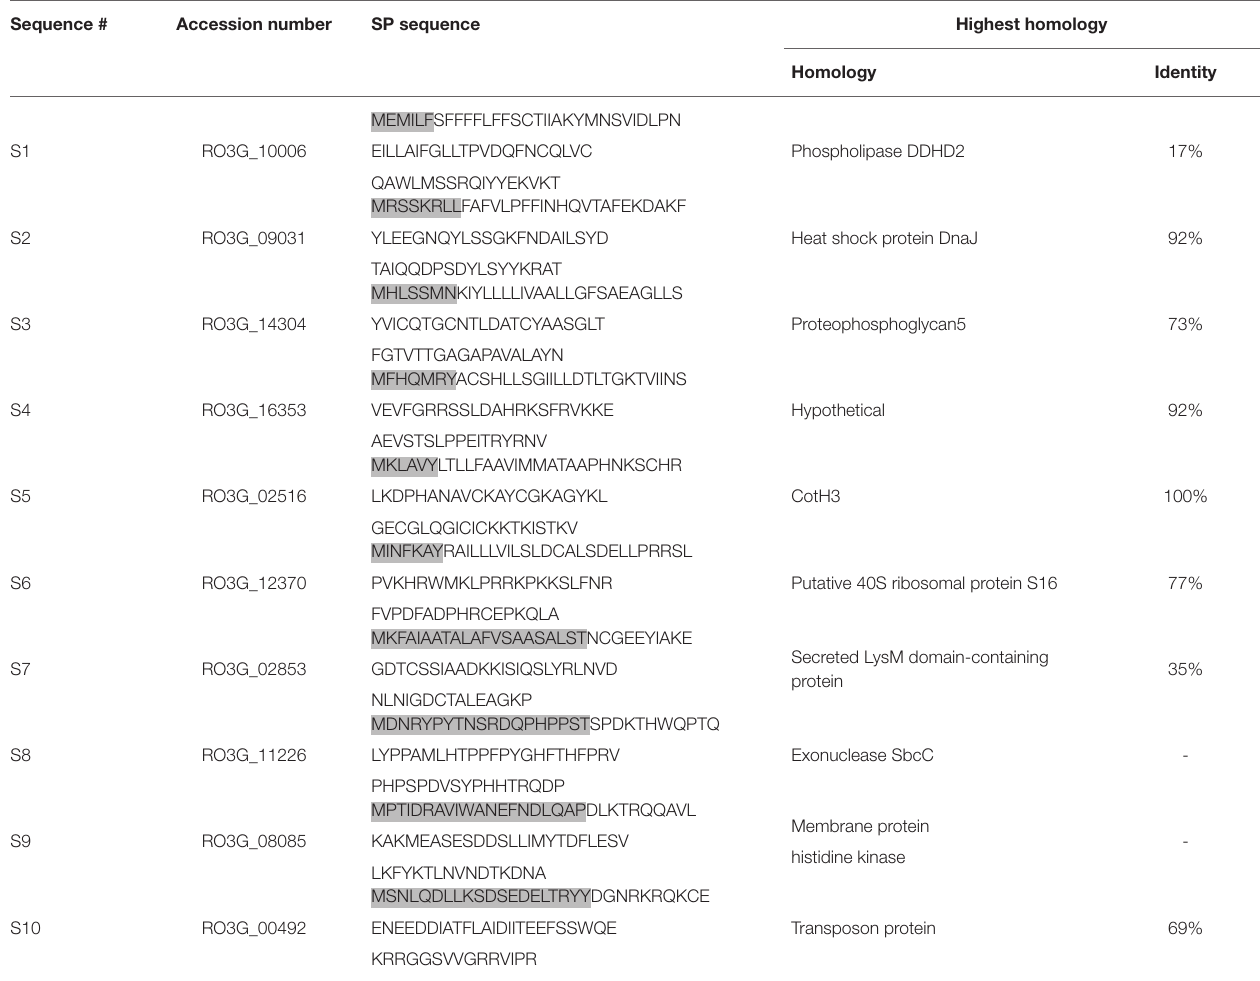
TABLE 1 | Predicted protein sequences with signal